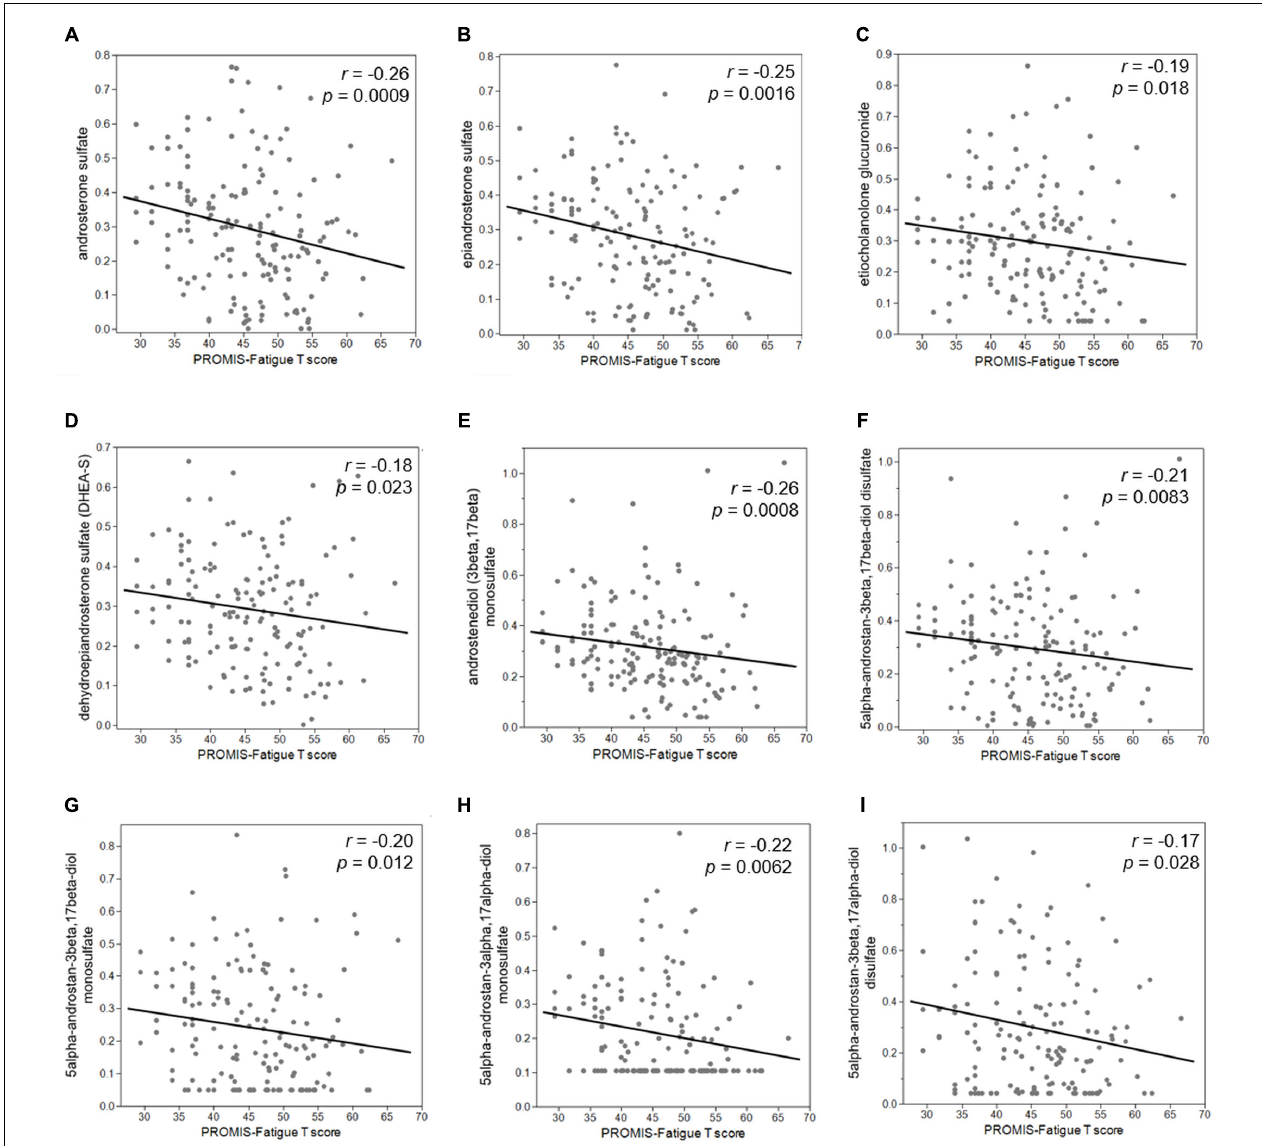
FIGURE 5 | Reduced steroid hormone biosynthesis metabolites were associated with increased severity of cancer-related fatigue. PROMIS-Fatigue T -scores significantly correlated with major androgen metabolites including (A) androsterone sulfate ( r = –0.26, p = 0.0009), (B) epiandrosterone sulfate ( r = –0.25, p = 0.0016), (C) etiocholanolone glucuronide ( r = –0.19, p = 0.018), and (D) dehydroepiandrosterone sulfate (DHEA-S) ( r = –0.18, p = 0.023). PROMIS-Fatigue T -scores also correlated with sulfated metabolites of androgen including (E) androstenediol (3beta,17beta) monosulfate ( r = –0.26, p = 0.0008), (F) 5alpha-androstan-3beta,17beta-diol disulfate ( r = –0.21, p = 0.0083), (G) 5alpha-androstan-3beta,17beta-diol monosulfate ( r = –0.20, p = 0.012), (H) 5alpha-androstan-3alpha,17alpha-diol monosulfate ( r = –0.22, p = 0.0062), and (I) 5alpha-androstan-3beta,17alpha-diol disulfate ( r = –0.17, p =